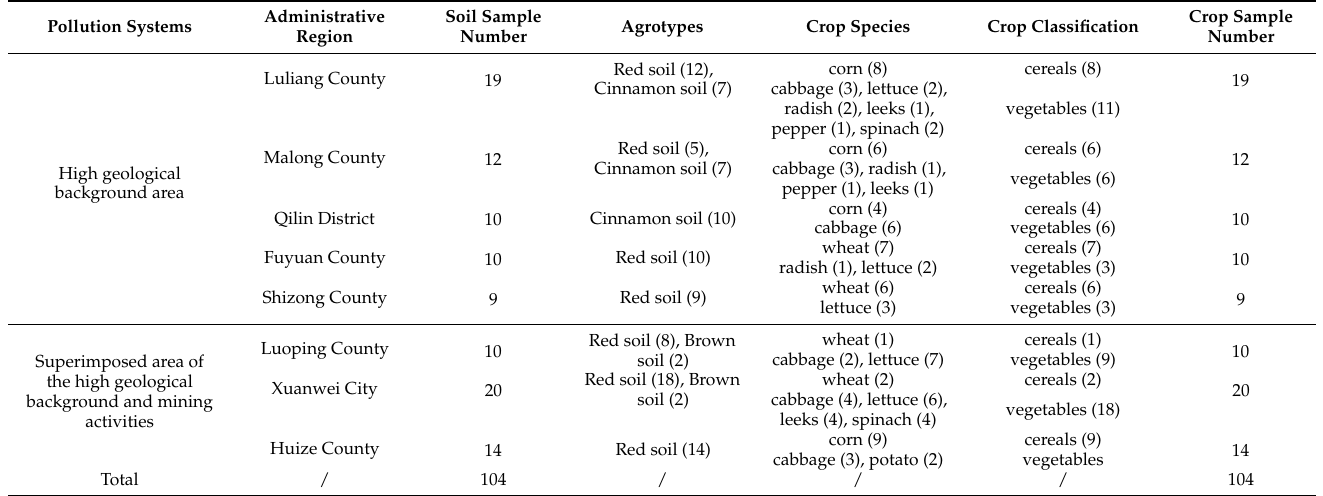
Table 1. The soil-crop (edible part) collaborative samples collected from two distinct pollution